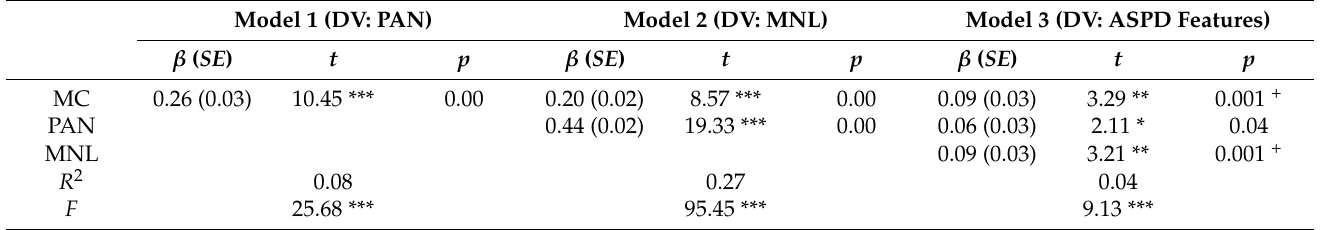
Table 3. All regression equations testing mediation models with maternal control as the independent